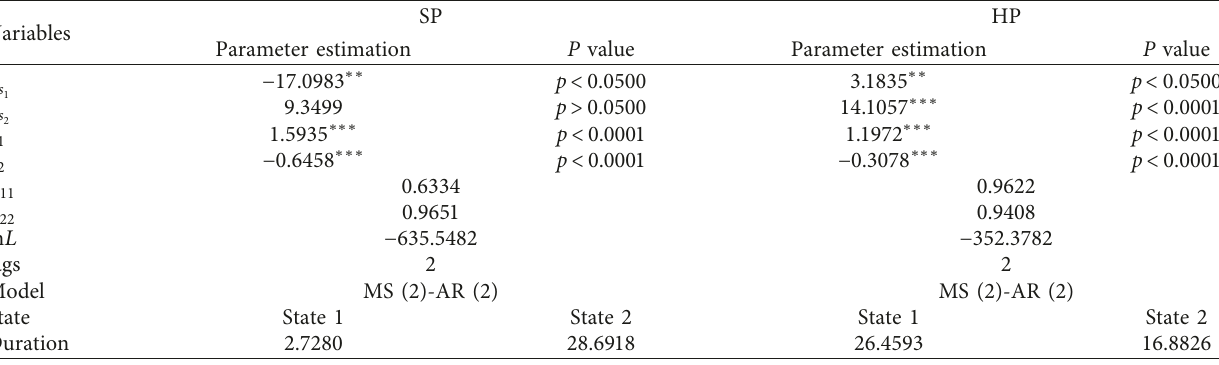
Table 3: Parameter estimation of the MS-AR (2) model.